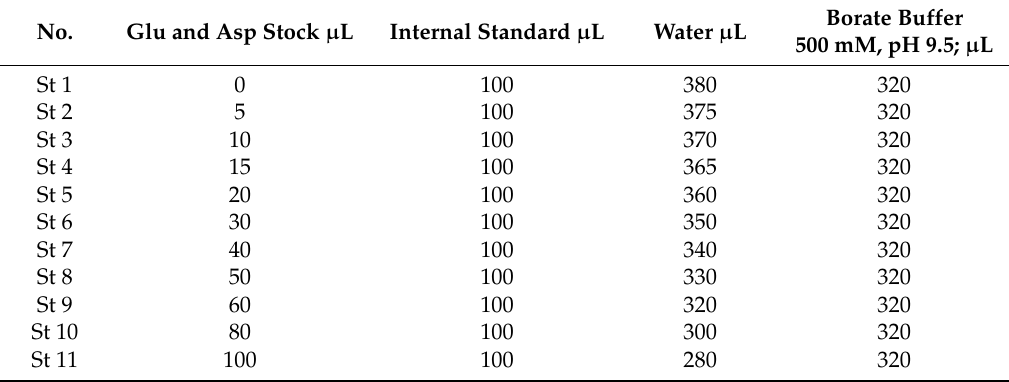
Table A3. Preparation of